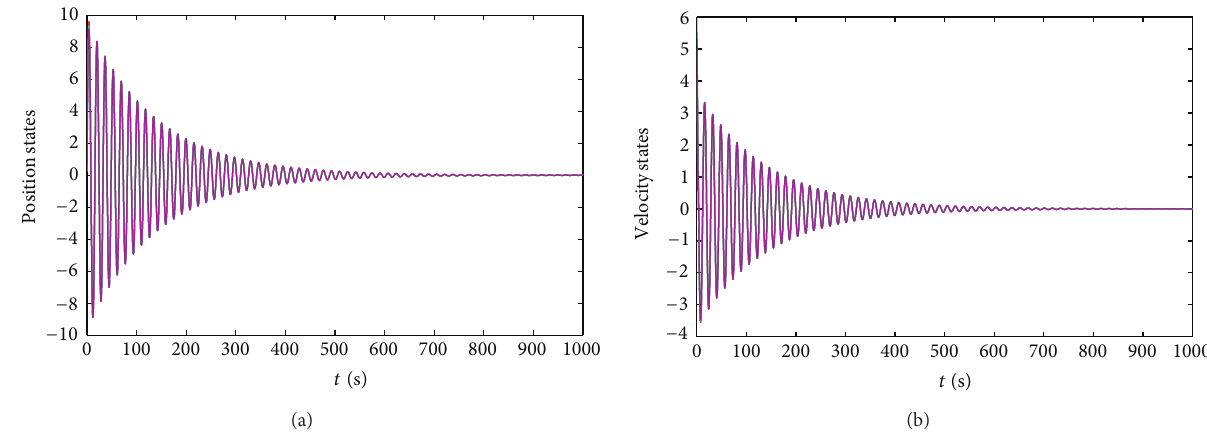
Figure 2: Velocity and position states of five agents in a network under linear consensus protocols where 𝜏 = 0.39 < 𝜏 0 .